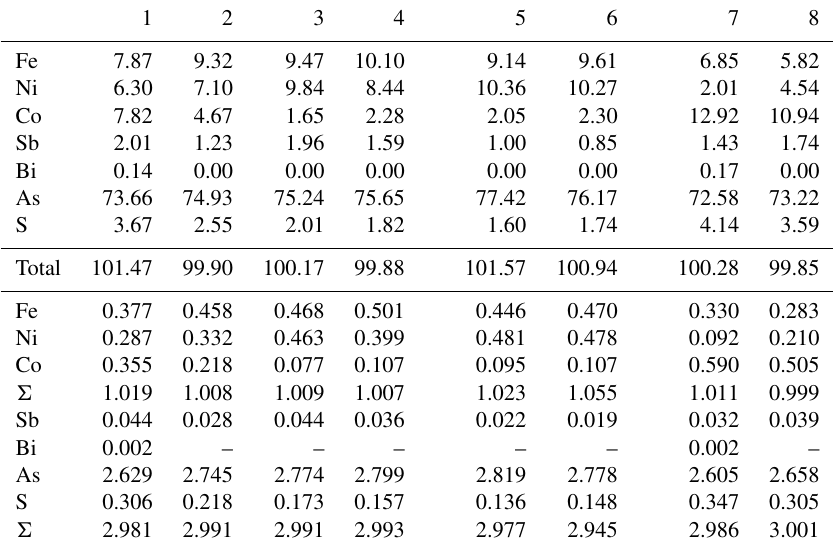
Table 8. Representative analyses (wt%) for members of the skutterudite subgroup from